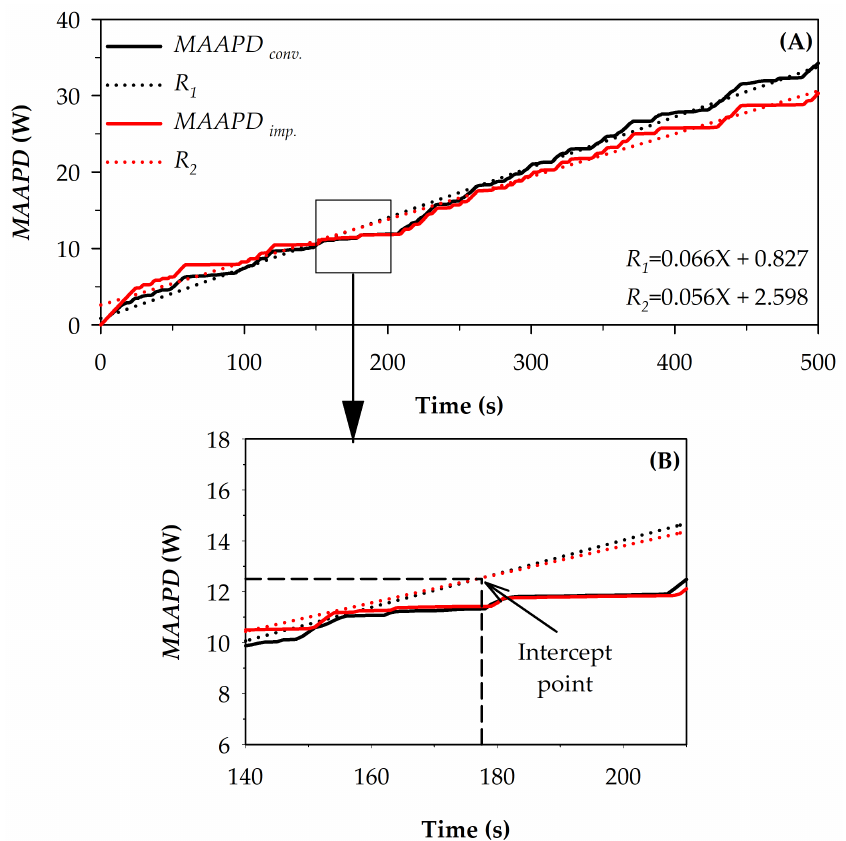
Figure 14. A comparison of MAAPD for conventional and improved HPTO unit models in sea state A, ( A ) MAAPD profile for 500 s and ( B ) enlarged image focused on the intercept point between R 1 and R 2 .